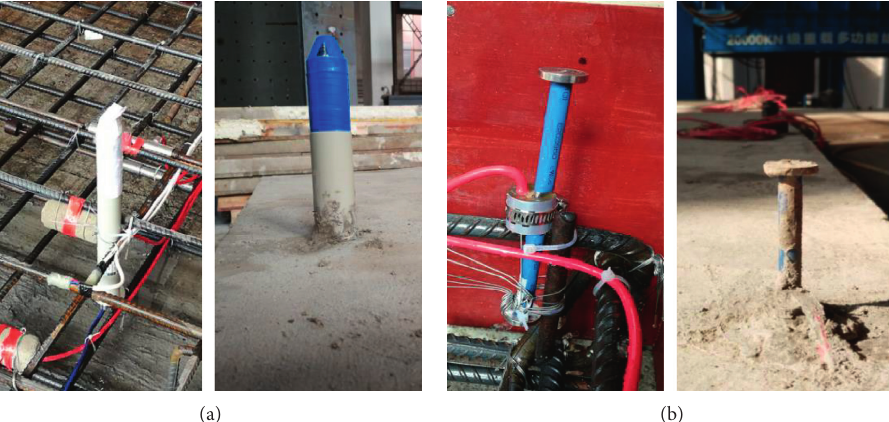
Figure 7: The layout of interlayer deformation measuring sensors: layout of the (a) embedment jointmeters and (b) embedment strain